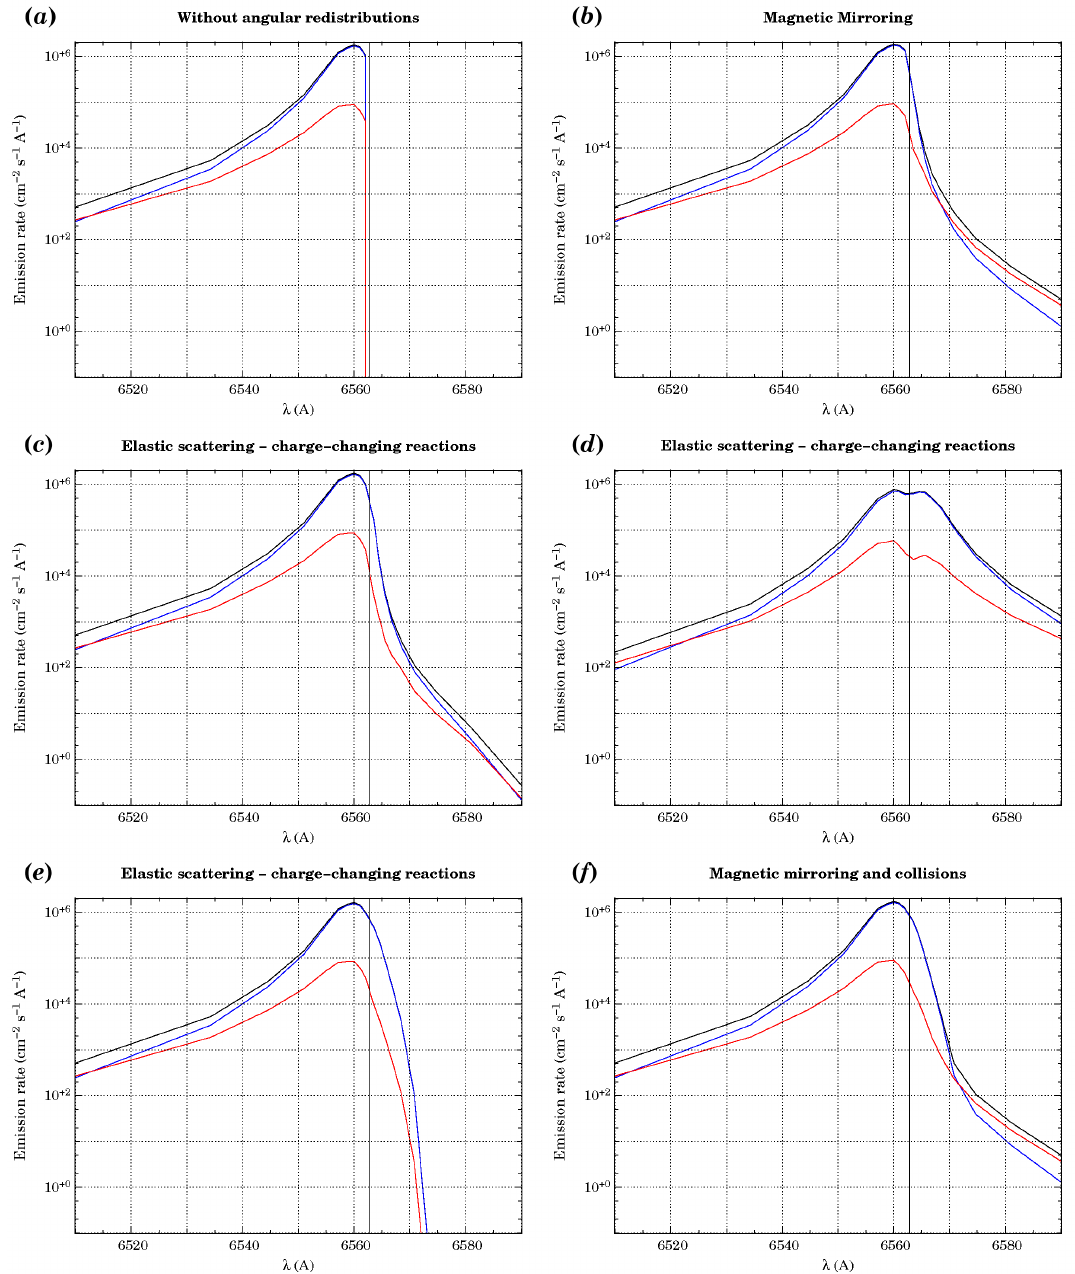
Fig. 3. H α spectra computed by TRANS4 with initial DMSP proton fluxes, drawn together with the centred wavelength λ 0 =6562.8 ˚A. The overall integrated emission rate is shown in black, and the contribution from the hydrogen flux and the proton fluxes are shown in blue and red, respectively. In panel (a) , the results without angular redistributions of magnetic or collisional origins are shown. Only a 3- ˚A blue- shifted peak is seen. Panel (b) : with magnetic mirroring, a narrow red-shifted tail appears which extends to a few ˚Angstr¨oms off the centred wavelength. Panels (c) and (d) : collisional angular redistributions make the line more symmetric. Here different configurations are shown for both phase functions of elastic and charge-changing scattering: Maxwellian distributions with successively σ =0.05 (c) and σ =0.20 (d), and the more accurate approach of Rutherford (e) . The spreading of the line with increasing angular scattering is clearly visible. Panel (f) : combined contributions for magnetic mirroring effects and elastic scattering using Rutherford